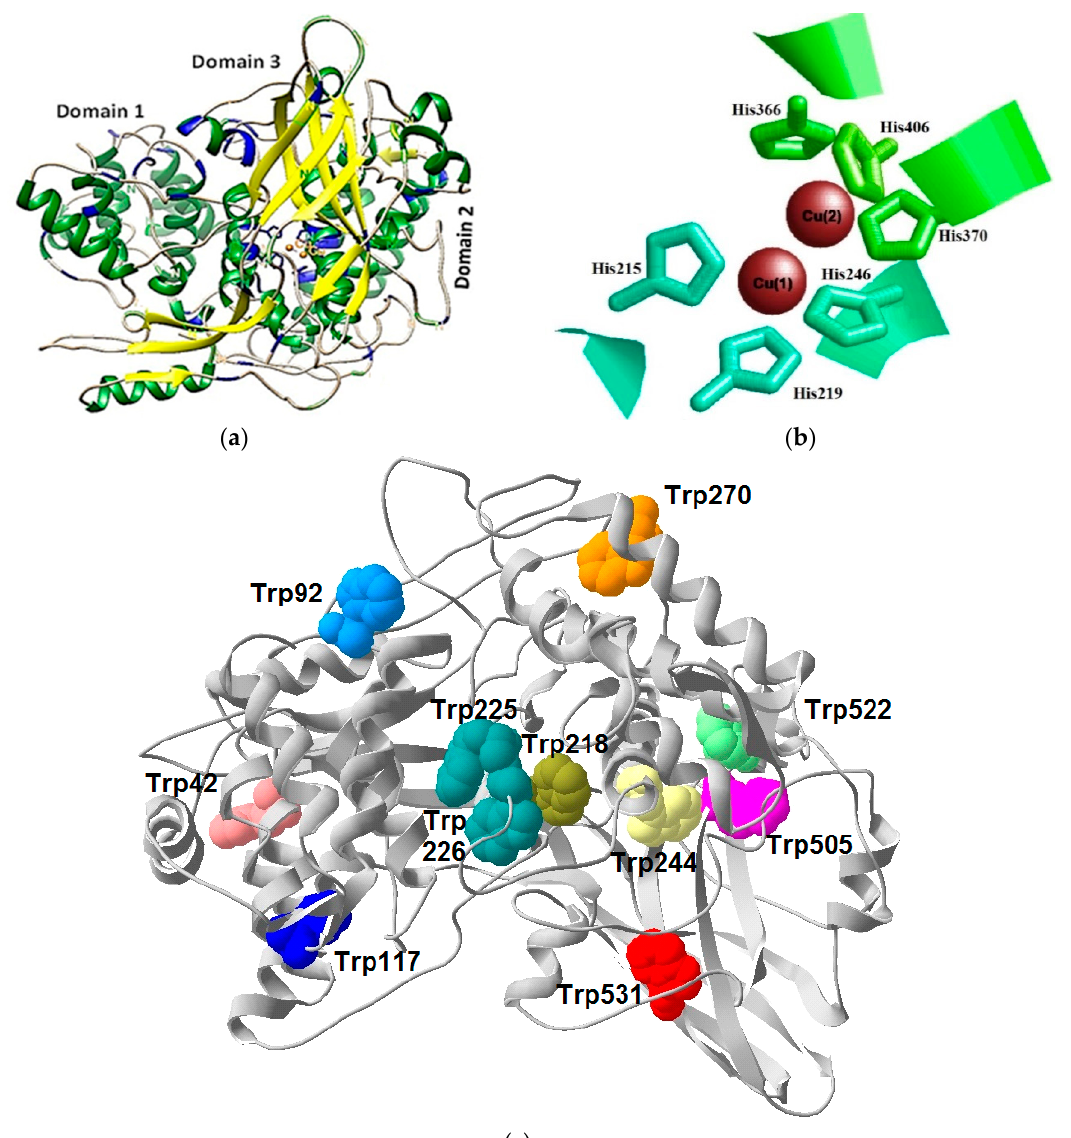
Figure 4. ( a ) Ternary and secondary structure of EvHc5— α -helices (green), β -strands (yellow), random coils (gray). Areas of the chain which carry His residues are colored in blue; ( b ) Active sites of Domain 2 with two Cu ions (brown) and His residues (CuA—215, 219 and 246; CuB—366, 370 and 406; ( c ). Positions of the Trp residues (42, 92, 117, 218, 225, 226, 244, 270, 505, 522, 531) in the EvHc5.